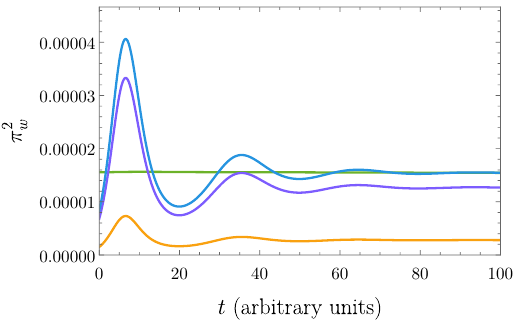
Figure 3 . The convergence of (cid:25) 2 hyperin(cid:13)ation solution (green) of example 5 with N f =